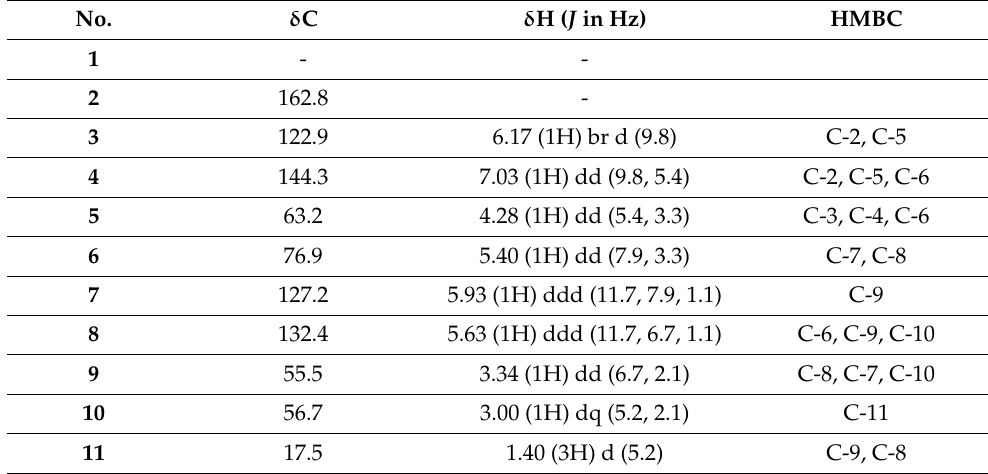
Table 1. NMR data of diplopyrone C ( 1 ) in CDCl 3 1,2 . No. δ C δ H ( J in Hz) HMBC